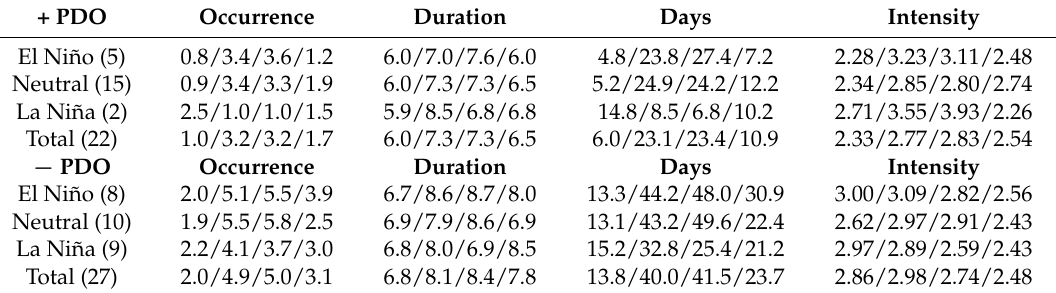
Table 9. As in Table 6, except for SH blocking